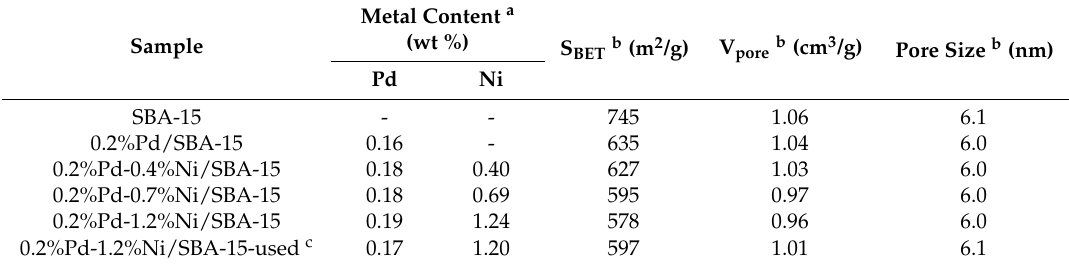
Table 1. Relevant physicochemical properties of the different